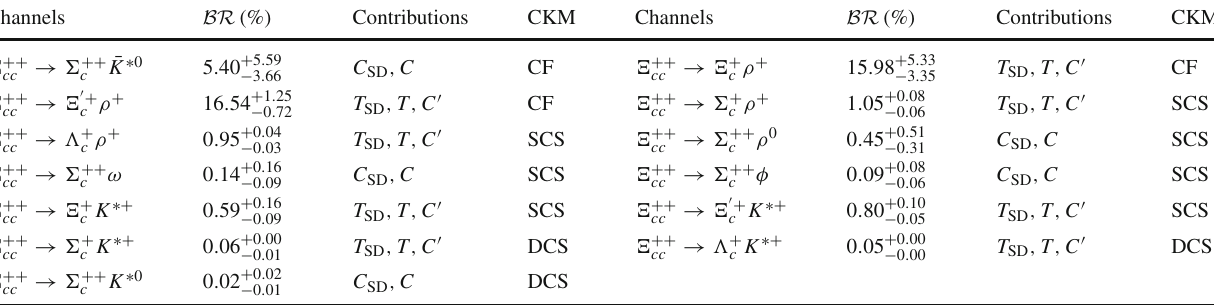
Table 2 Our results for branching ratios of (cid:2) ++ cc → B c V and cor- responding topological contributions. The “CF”, “SCS” and “DCS” represent CKMfavored, singlyCKMsuppressed anddoubly CKMsup-